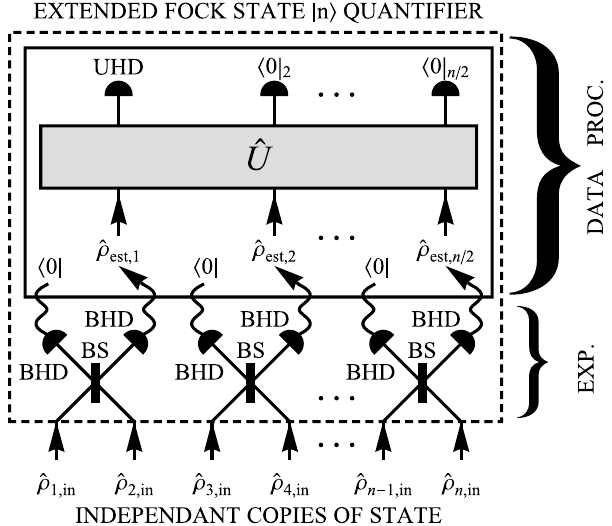
Figure 4. A pictorial representation of the advanced quantifier composed of the experimental part and data processing. The experimental part (EXP.): BS - the balanced beam splitter, BHD - the balanced homodyne detector. Data processing (DATA PROC.) in terms of virtual physical operations: 〈 0| - the projection to vacuum (provided by a conditional data selection), ρ ˆ - the density matrices after the experimental part of the protocol est i , estimated from data measured on BHD, ˆ U - the unitary transformation for photon creation operators representing a linear optics network, 〈 0| i - the detection projecting the i -th output mode to vacuum state, UHD - the unbalanced homodyne detection measuring the Wigner function of the output of the unitary